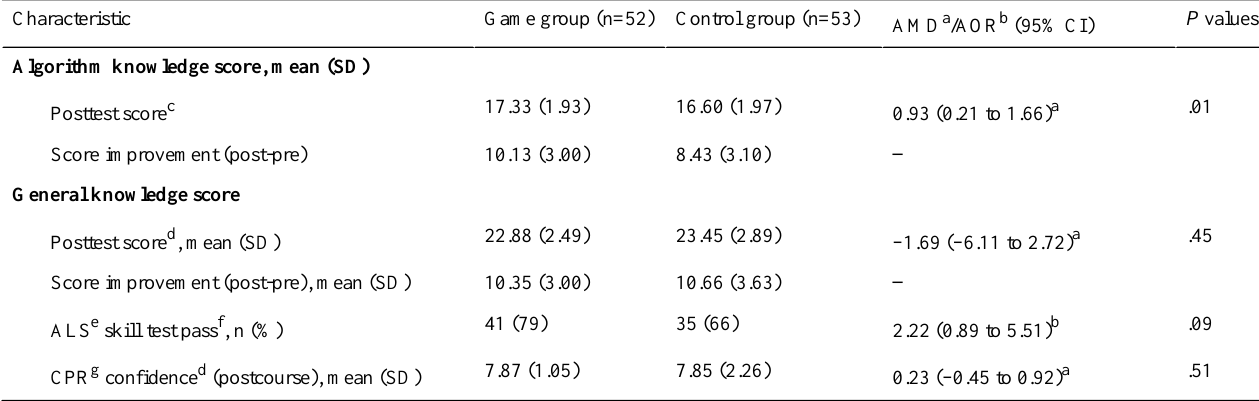
Table 2. Comparison of learning outcomes between the game group and control